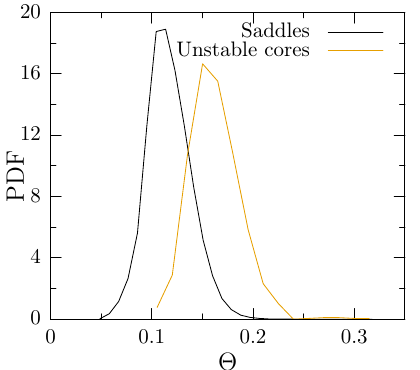
Figure 11: Probability density functions of the Θ order parameter for all particles in the saddles sampled at T = 0.28 (black line) and for particles belonging to the cores of the unstable modes (orange